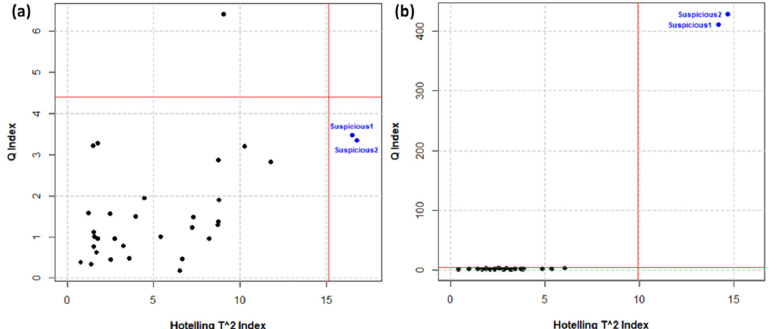
Figure 4. One-class classification influence plots of the suspicious samples onto PCA models of ( a ) “grappa” and ( b ) “wine spirit” samples. Black points represent the TrS samples, blue points the suspicious ones. Red lines are the acceptability limits for T 2 and Q statistics at a significance level of 0.05. Analytica 2021 , 2 , FOR PEER REVIEW